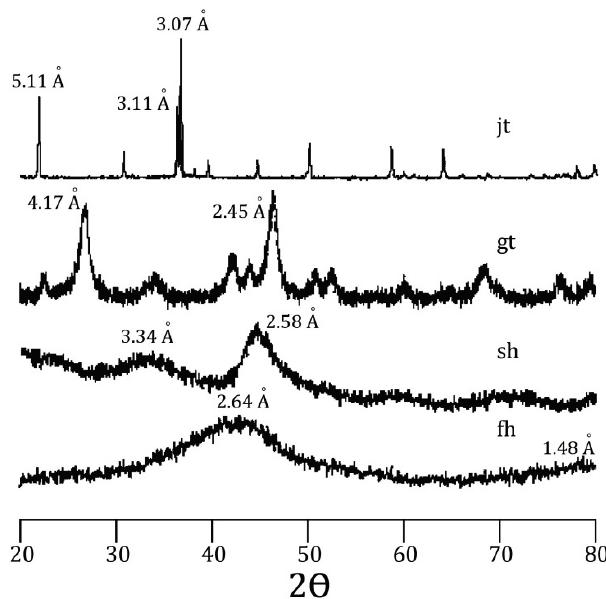
Figure 1. X-ray diffraction pattern for jarosite (jt), goethite (gt), schwertmanntite (sh), and ferrihydrite (fh).